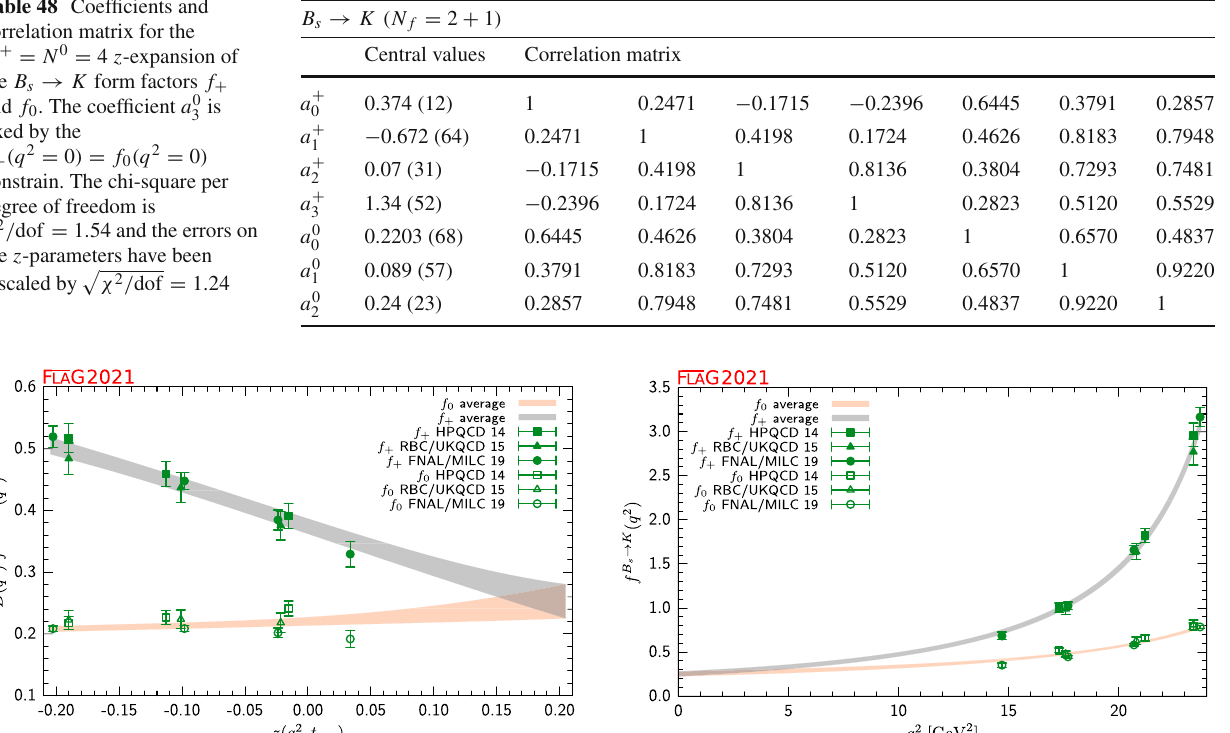
Fig. 32 The form factors f + ( q 2 ) and f 0 ( q 2 ) for B s → K (cid:6)ν plotted versus z (left panel) and q 2 (right panel). In the left plot, we remove the Blaschke factors. See text for a discussion of the data sets. The grey and salmon bands display our preferred N + = N 0 = 4 BCL fit (seven